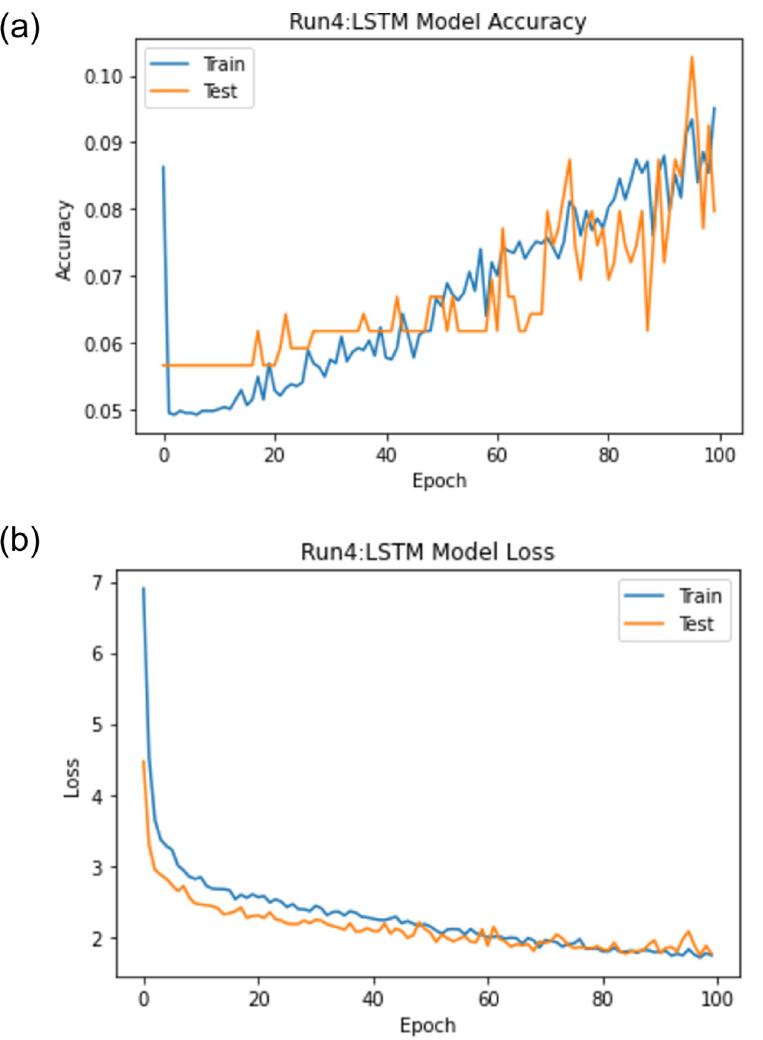
Fig 17. The LSTM-GWO accuracy and loss with experiment